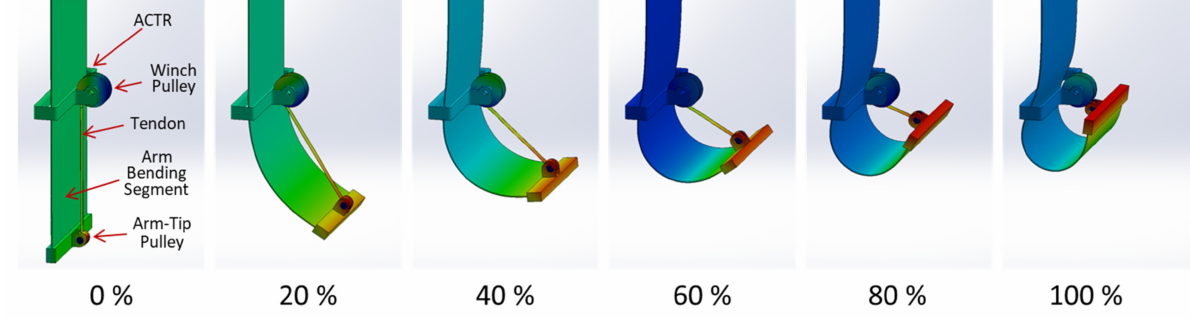
Figure 8. The manipulator during FEA simulation. The images indicate the bending percentage.